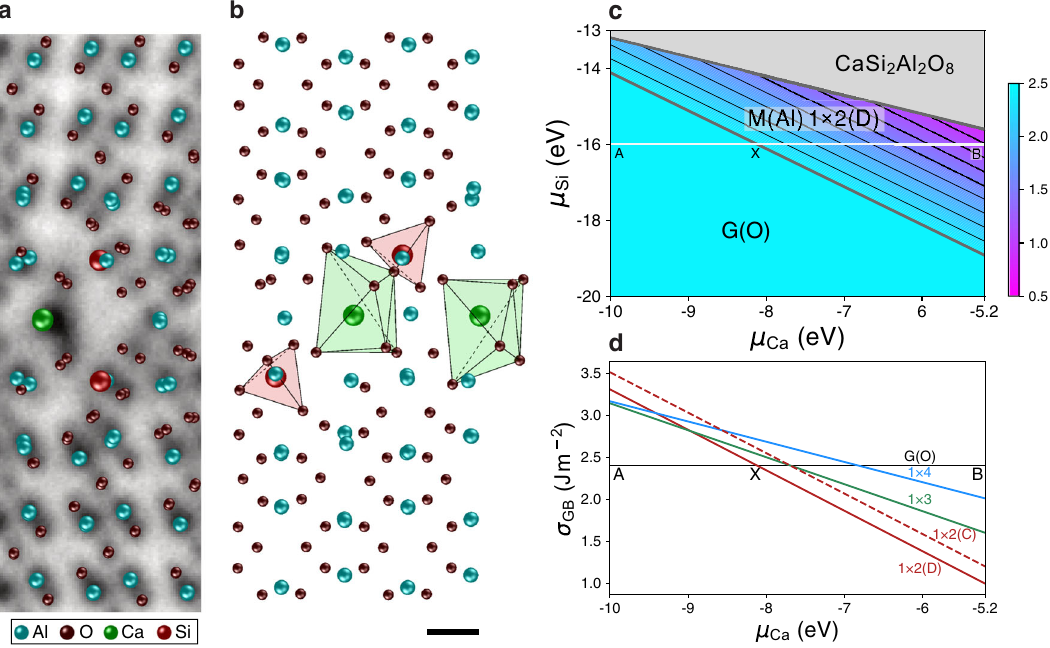
Fig. 3 | The relaxed atomic structure and the GB energy of Ca/Si co-doped Σ 13 M(Al) GB. The structure model is viewed along the a ½ 11 (cid:1) 20 (cid:2) axis and b ½ (cid:1) 2021 (cid:2) axis, wherethestructuremodelin a isoverlaidontheABF-STEMimage.Al,O,Ca,andSi atoms are represented by the colors cyan and dark red, green, and light red, respectively.Thestructuraltetrahedron(palered)andoctahedron(palegreen)for